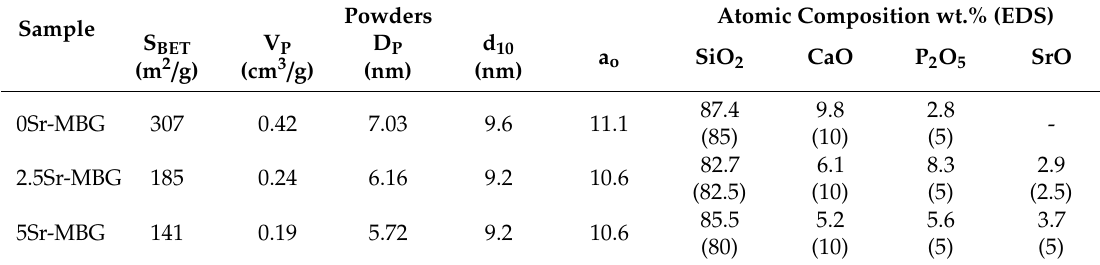
Table 2. Textural properties of the powders (S BET , V P and D P ) obtained by N 2 adsorption. Interplanar d 10 spacing, obtained by X-ray di ff raction (XRD), and calculated unit cell parameters (a o ). Composition in oxides of each MBG was determined by EDS, including the intended nominal values in brackets. The error of mean values represents a coe ffi cient of variation of < 7% for each experimental value in the table.